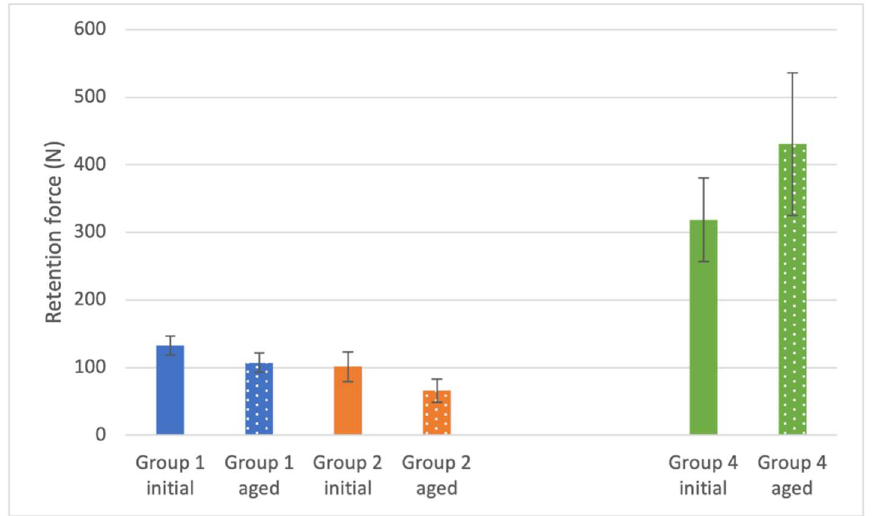
Figure 4. Retention force of the restorations ( n = 8 per group). Table 2. Retention force means and standard deviations. Statistically significant differences between groups determined with Fisher-LSD post-hoc test are indicated with varying superscript letters ( p > 0.05) (upper case horizontal, lower case vertical).